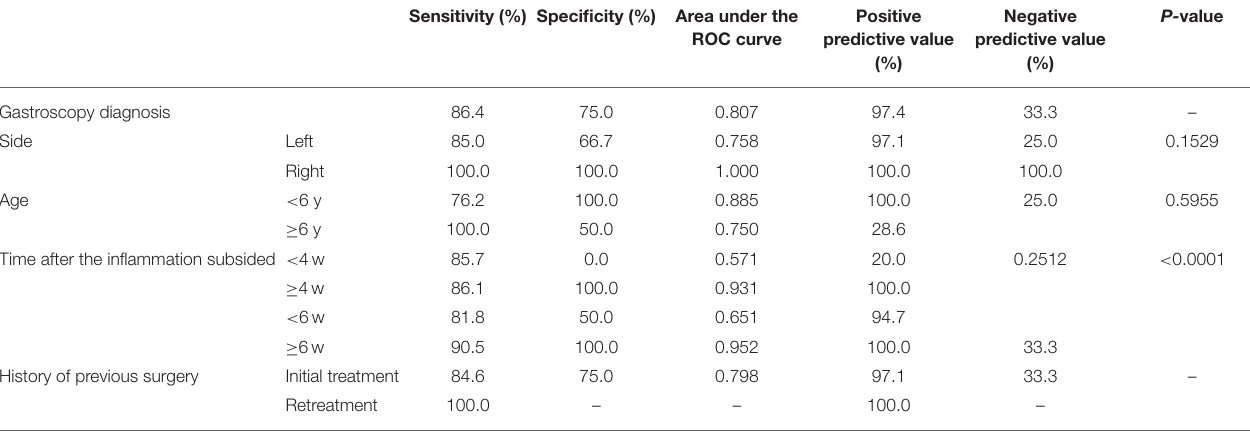
TABLE 4 | Diagnostic reliability of gastroscopy under local